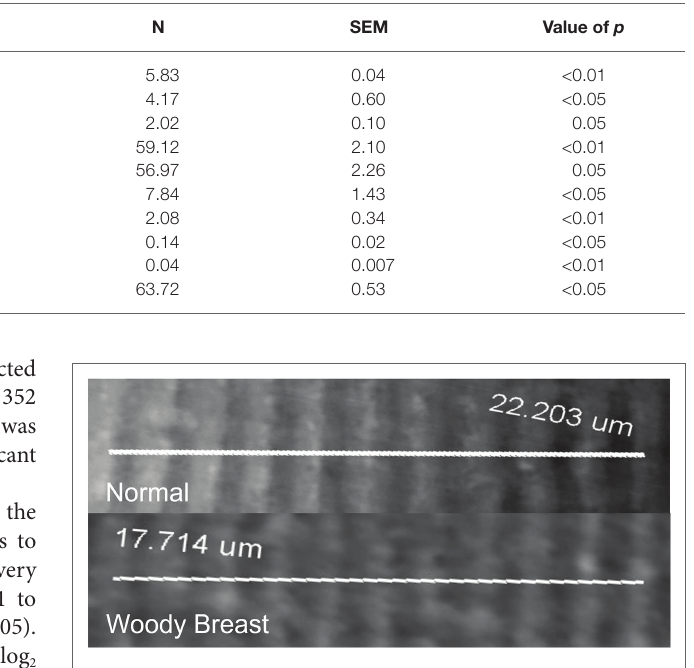
FIGURE 2 | Representative images of Woody Breast (WB) and normal (N) Pectoralis Major muscle fiber used to quantify sarcomere